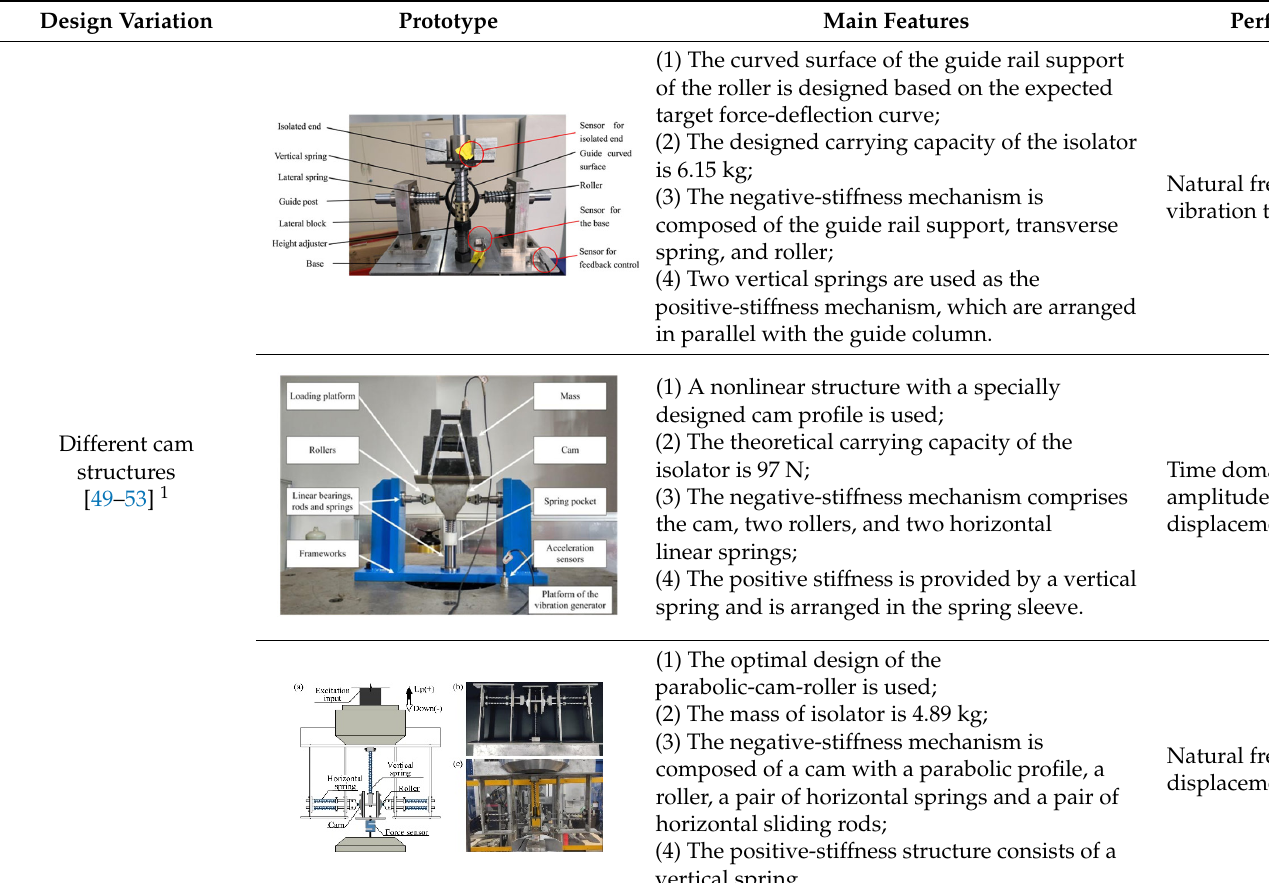
Table 2. Overview of different types of cam-roller-spring QZS vibration isolators.